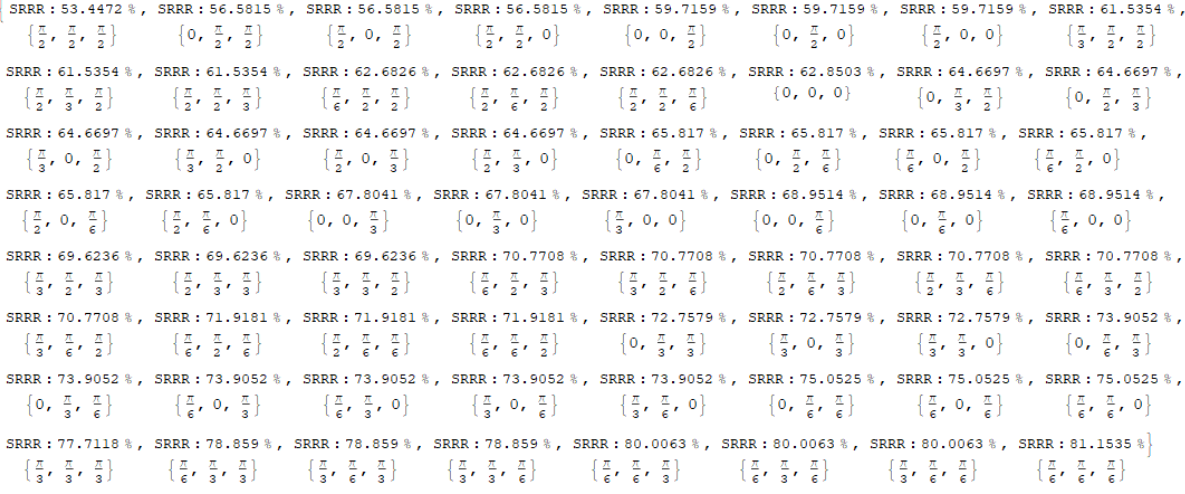
Figure 13. Solar Radiation Reception Rate for m = 3 and n = 3 at the summer solstice in the region of